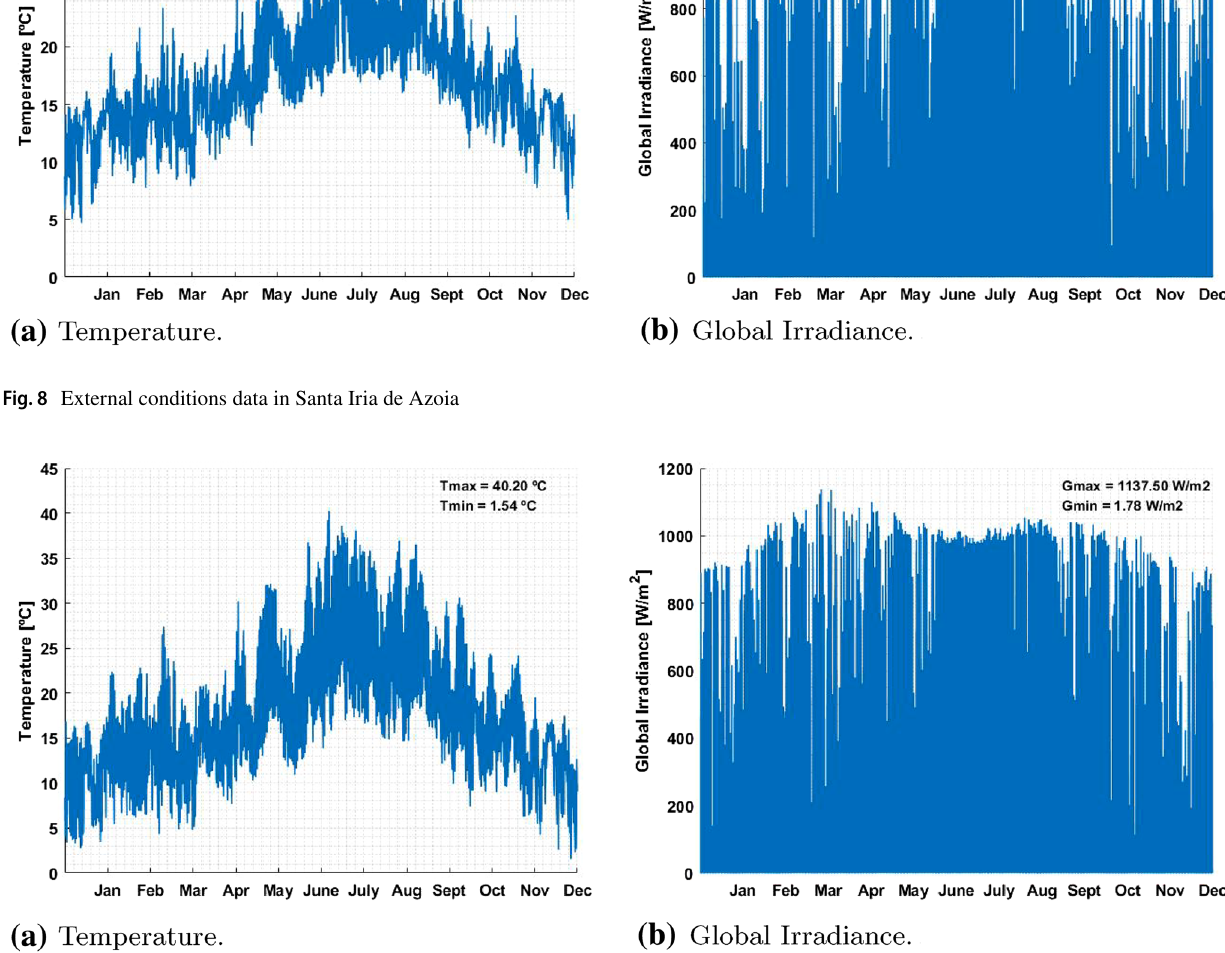
Fig. 9 External conditions data in Castro